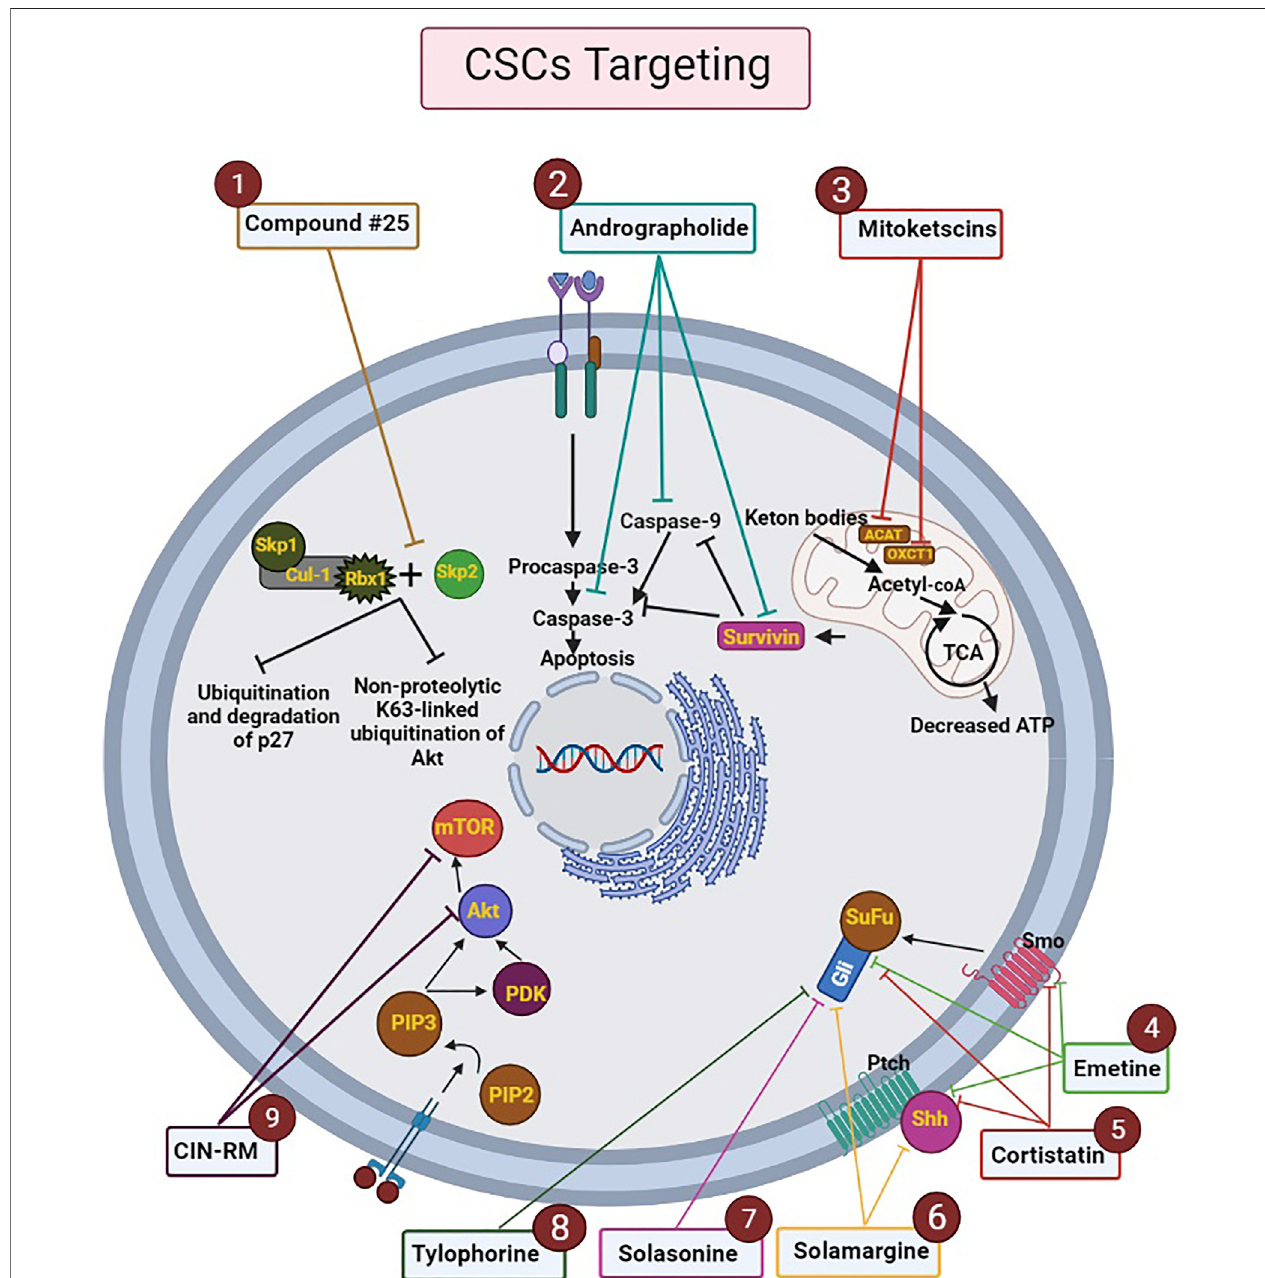
FIGURE3| Mechanism ofaction ofdrugsanalyzedbymoleculardockingonthemetabolicprocesses ofCSCs. Theligandsand targets havebeen investigated by moleculardocking. Nineeffective drugs, including compound #25,andrographolide,mitoketoscins,emetine,cortistatin, solamargine,solasonine,tylophorine,and CIN- RM are known to affect the biological processes and signaling pathways of CSCs. 1) Compound #25 prevents the assembly of the Skp2-SCF complex by binding to Skp2. Hence, it inhibits two pathways including non-proteolytic K63-linked ubiquitination of Akt and ubiquitination and degradation of p27, which ultimately inhibit thedevelopmentoftumorfeatures.2)AndrographolideincreasesintrinsicapoptosisinCSCs(especiallyinbreastcancer)byinhibitingsurvivin,caspase-9,andcaspase- 3.3) Mitoketoscins stop the recycling of ketone bodies into Acetyl-CoA by inhibiting two proteins, including OXCT1 and ACAT1. Hence ATP production is stopped and oxidativemitochondrial metabolism inCSCs isinhibited.4) Emetine and 5)Cortistatin,can target CSCs bybindingtosonicHh, Smoand, gli protein. 6) Solamarginecan affect sonic hedgehog and gli proteins by its pharmacophores. 7) Solasonine and 8) Tylophorine modulate the Hh pathway by affecting gli proteins. 9) CIN-RM can lead to upstream inhibition of the Akt pathway and reduction of CSCs markers, which decrease the expression level of transcription factors involved in self-renewal, such as c-Myc, Nanog, Oct4, and Sox2. CIN-RM can inhibit mTOR pathway. Abbreviations: ATP, Adenosine triphosphate; CIN-RM, Hydroquinone 5-O-cinnamoyl ester of renieramycin M; CSCs, Cancer stem cells; Hh, Hedgehog; mTOR, Mammalian target of rapamycin; Smo, smoothened (Chan et al., 2013; Hongwiangchan et al., 2021; Jaitak, 2016; Liu et al., 2014; Madhunapantula et al., 2011; Ozsvari et al., 2017; Wanandi et al., 2020).